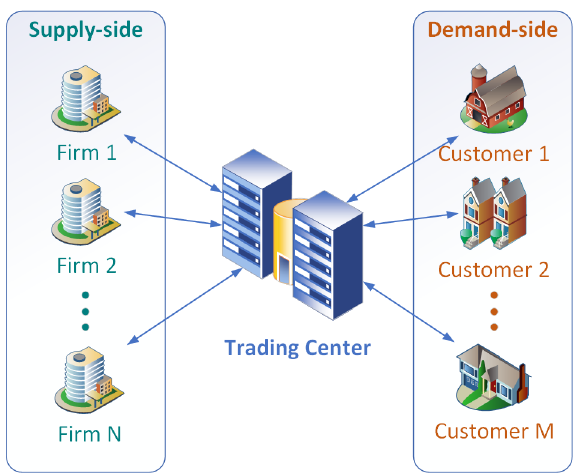
Figure 2. Architecture of double-sided game with N firms and M customers.